Question: In a single sentence, describe what this figure presents.
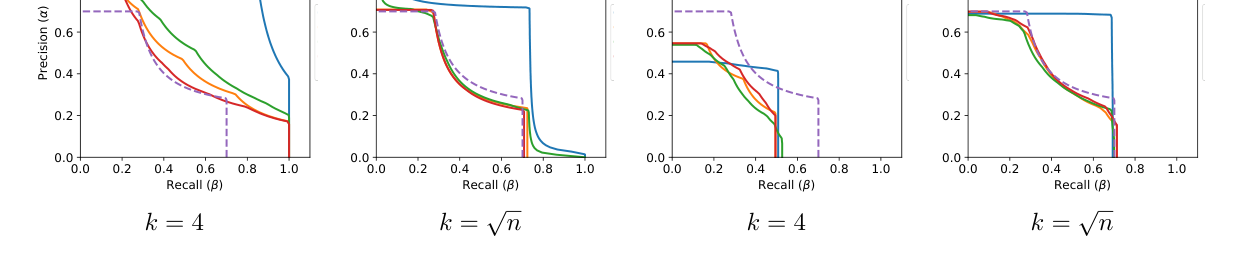
Answer: Comparing two Gaussian mixtures. This figure complements Fig. 3b. The Ground-Truth PR curve ( - -GT) is compared to empirical estimates from various NN-classifiers: –IPR, –KNN, –PARZEN, and –COVERAGE. Here P and Q are two GMMs sharing the same modes (centered at µk): P ∼P